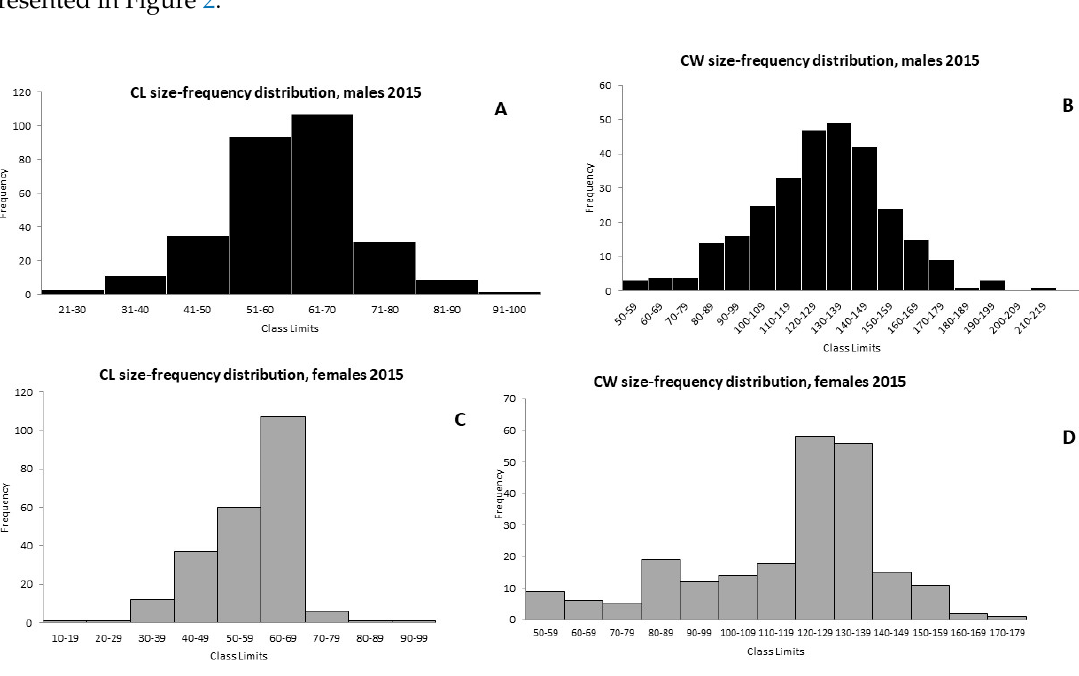
Figure 1. Size frequency distributions of Callinectes sapidus Rathbun, 1896. ( A ) carapace length (CL) frequency distribution in males, ( B ) carapace width (CW) frequency distribution in males, ( C ) carapace length (CL) frequency distribution in females and ( D ) carapace width (CW) frequency distribution in females.